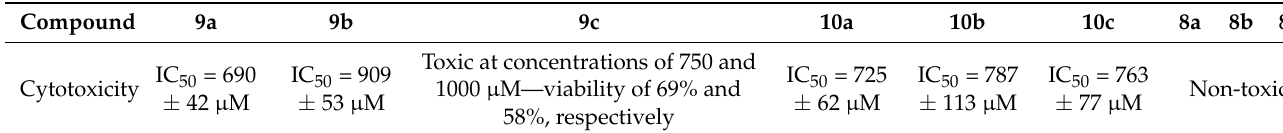
Table 2. Viability of the V79 cell line after treatment with compounds.